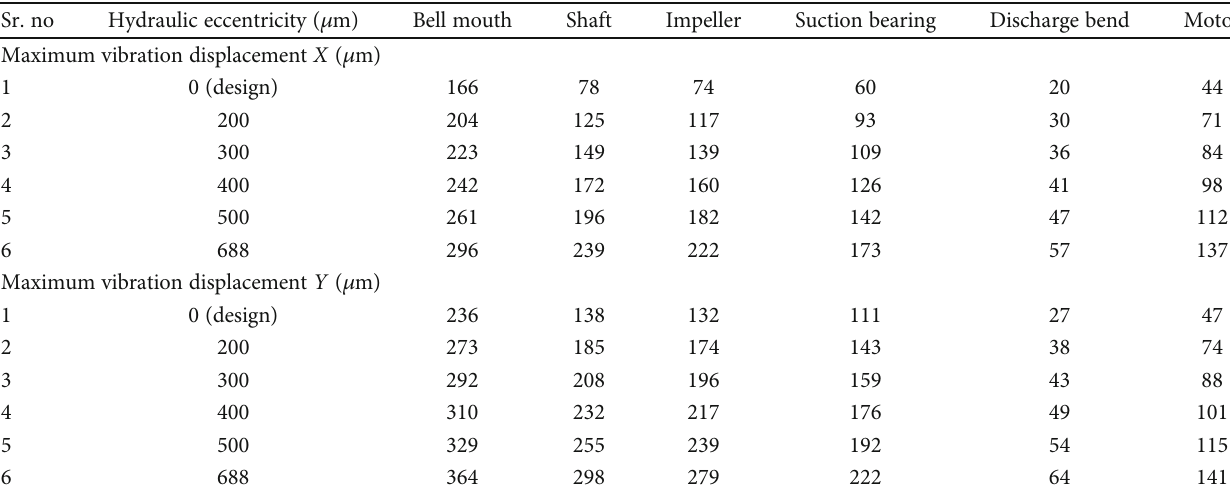
Table 4: Vibration displacement when the impeller is on hydraulic